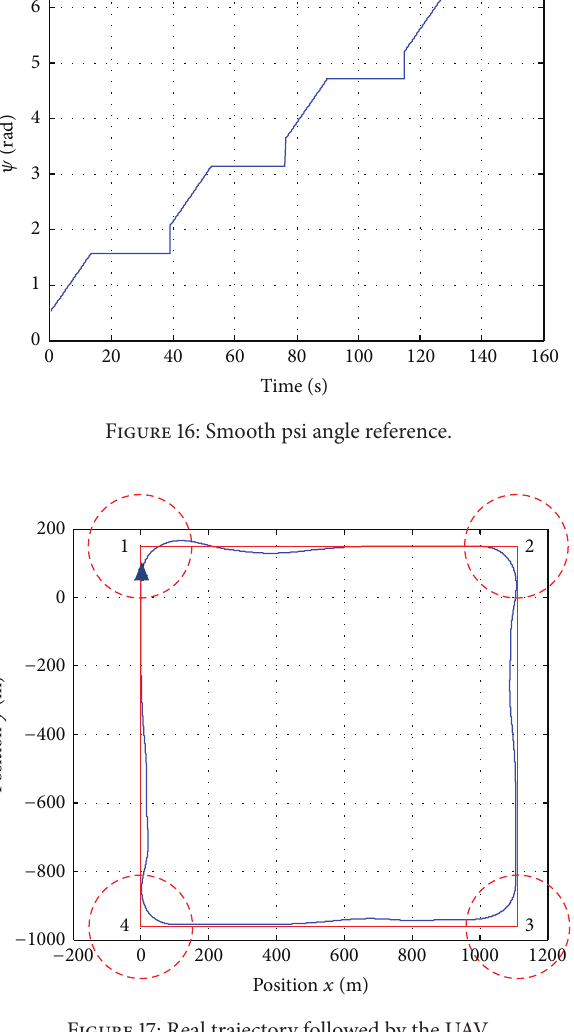
Figure 17: Real trajectory followed by the